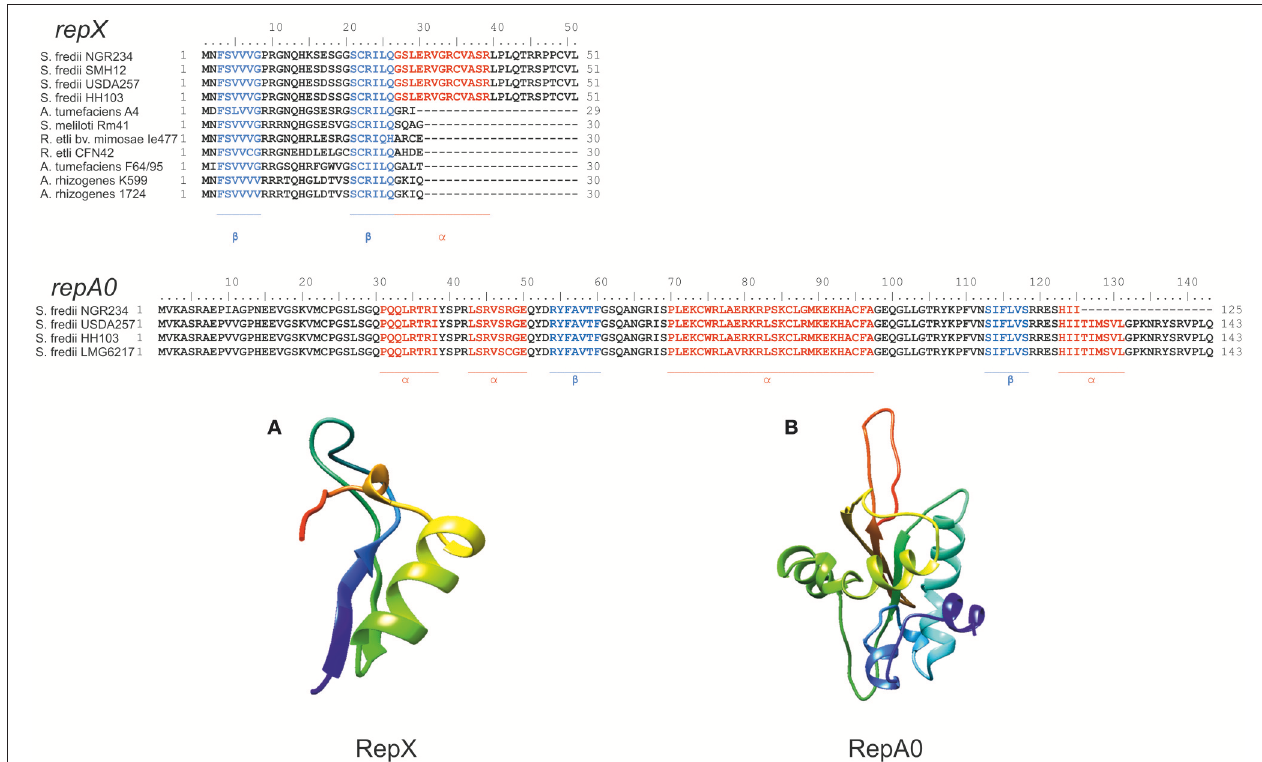
FIGURE 2 | Amino acid ClustalW Alignments of RepX (A) and RepA0 (B) and structure models of both proteins. Both models predict folded proteins with ß-sheets, α -helical and coiled regions. In the alignments (upper panel), red amino acids display probable components of α -helices and blue amino acids display components of β -sheets. In the 3D structures depicted in the lower panel the RepA0 3D model predicts two antiparallel-ß-sheets and two α -helical areas. The RepX model predicts one ß-sheet and one α -helical area. The analysis and sequence alignments were done with PROMALS3D (http://prodata.swmed.edu/promals3d/promals3d.php) and the 3D structure prediction was done using the web tool available at http://robetta.bakerlab.org.